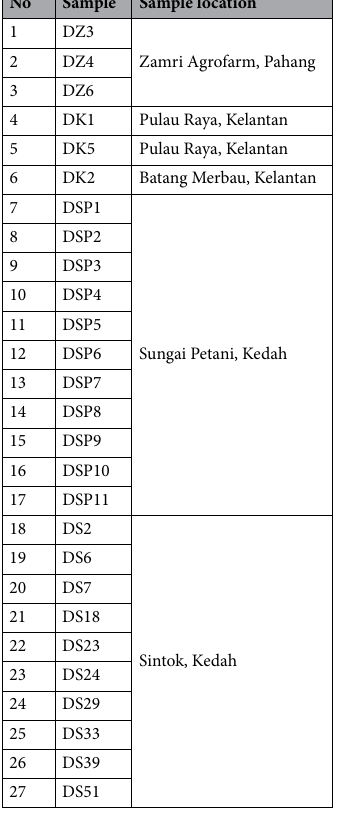
Table 5. Samples collection of MK from five different locations in Peninsular Malaysia .